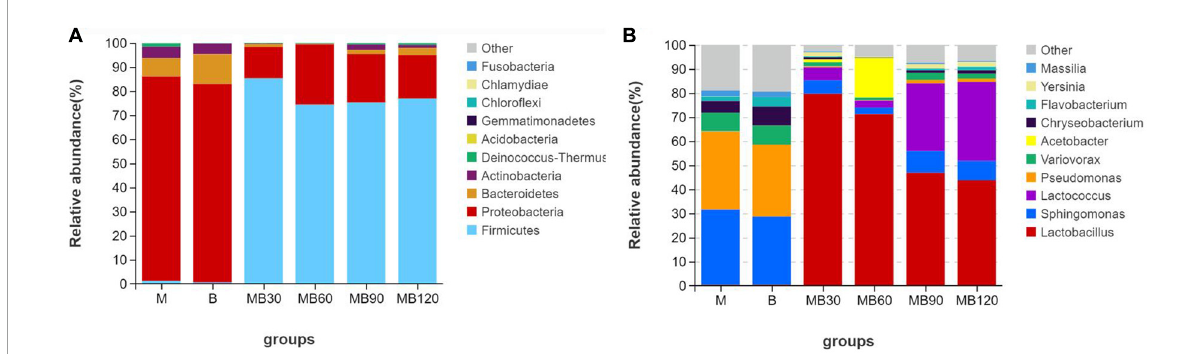
FIGURE4 Relative abundance of bacterial communities at the phylum (A) and genus levels (B) for fresh materials and ensiling. M, maize; B, faba bean; MB30, 30 days of mixed silage of maize and faba bean; MB60, 60 days of mixed silage of maize and faba bean; MB90, 90 days of mixed silage of maize and faba bean; MB120, 120 days of mixed silage of maize and faba bean.